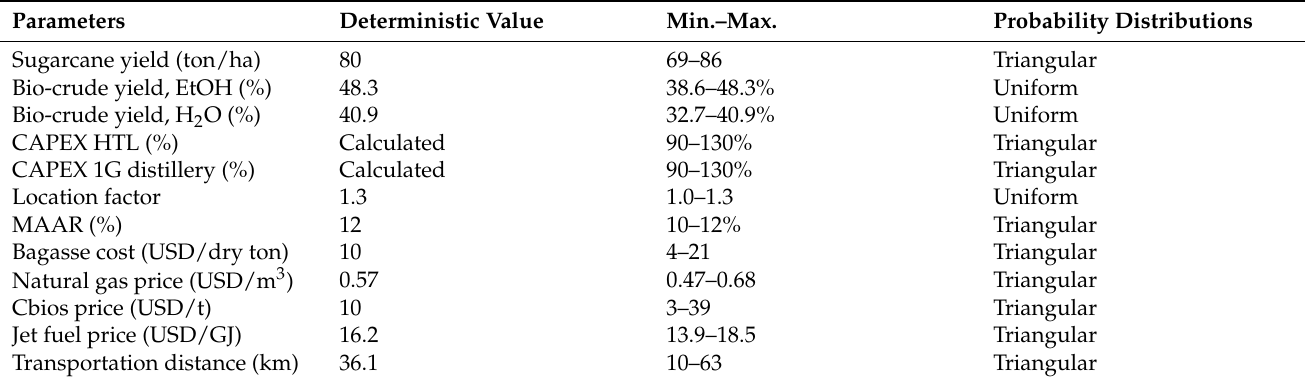
Table 4. Main parameters adopted for the uncertainty